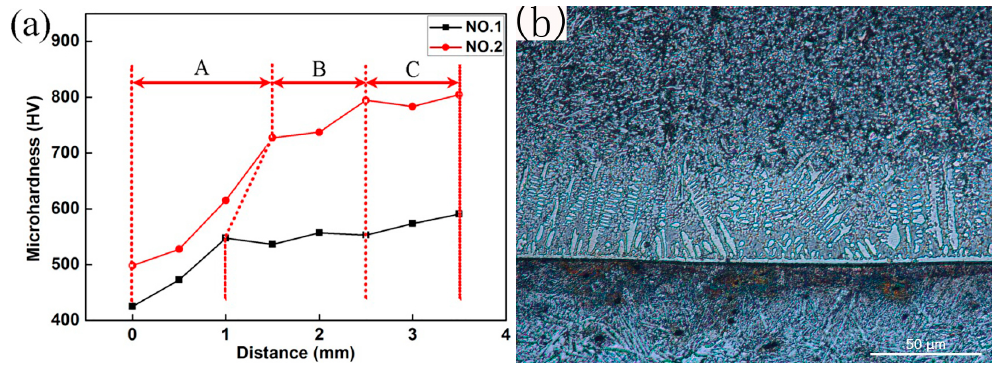
Figure 9. Microhardness of the coating: ( a ) cure of hardness; ( b ) microstructures of the coating and substrate No.1.